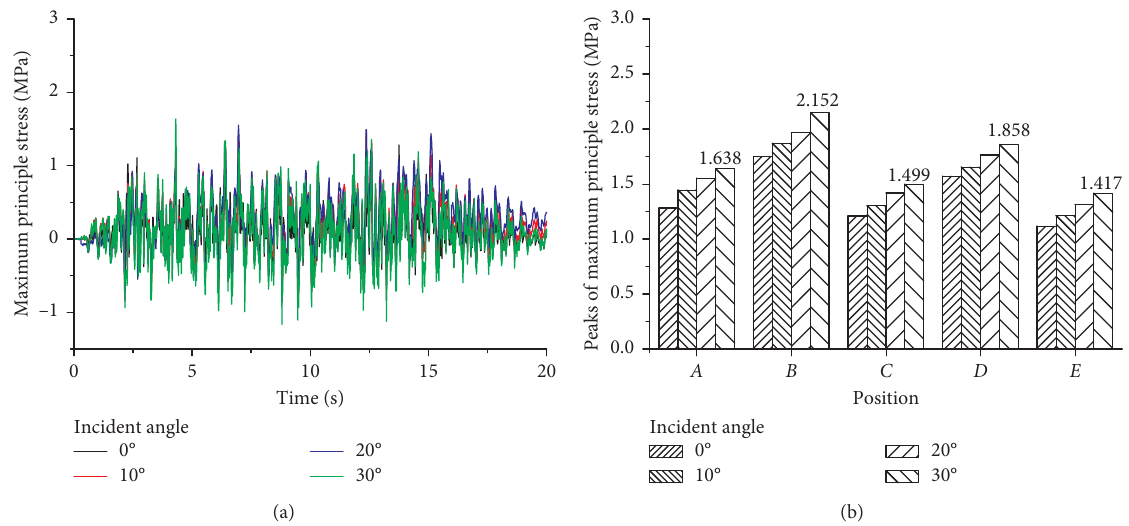
Figure 10: Maximum principal stresses under different incident angles: (a) stress time histories of point A and (b) peaks of maximum principal